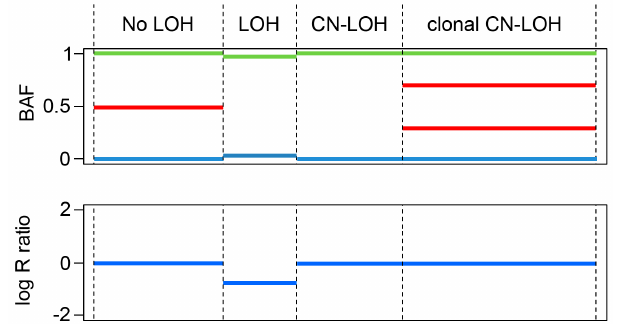
Figure 1. Schematic illustration of LOH assay using SNP arrays using the Illumina Infinium SNP Immunochip. The schematic genomic plots show patterns of B-allele frequency (BAF) (top panel) and corresponding log R ratios (bottom panel) along the analyzed chromosome (x-axis) demonstrating cases of heterozygosity (no LOH), LOH due to loss of genetic material (LOH), copy number neutral (CN-LOH) and clonal CN-LOH (a mixture of cells with CN-LOH and normal heterozygous cells). The lower plot shows the log R ratio, which is a measure of SNP CN variation, with a normal value defined as 0, reflecting a copy number neutral loss of heterozygosity